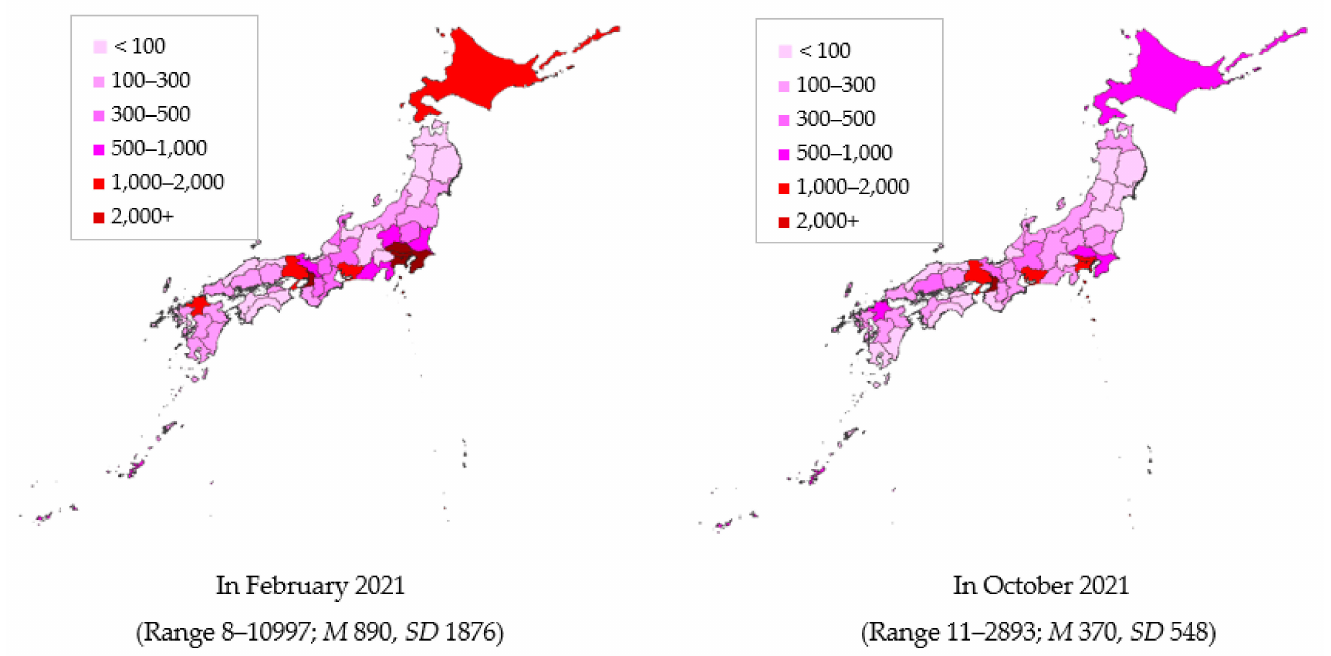
Figure 1. New COVID-19 infection cases by